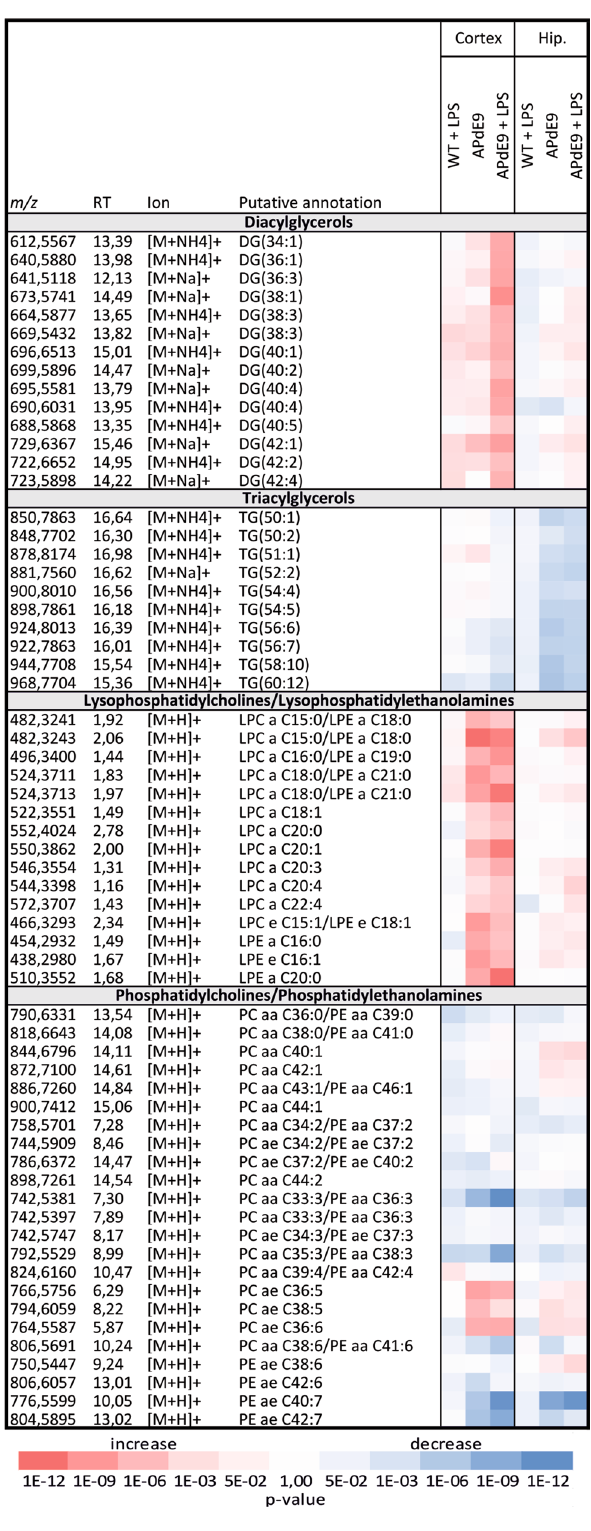
Figure 4. The heatmap of statistically significant and successfully annotated compounds represents the changes in the most affected lipid levels in the cortex and hippocampus of WT plus LPS (n = 11), APdE9 mice (n = 11), and APdE9 plus LPS (n = 9) groups versus WT control (n = 11). Heatmap of p values without correction − log10 scaled, red—increased lipids (fold-change > 0), blue—decreased lipids (fold-change < 0). The statistical significance after Bonferroni correction was considered as a p value < 3.48 × 10 −5 . Details of the metabolites are provided in Supplementary Table S2